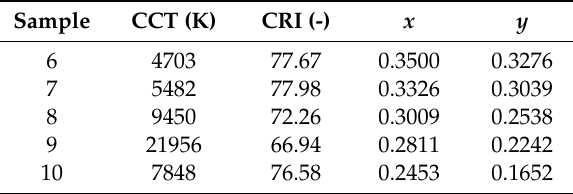
Figure 13. Measured CRI ( a ) and CCT ( b ) values for samples 6–10 with excitation using the LD PL450B. Table 6. CCT, CRI and color coordinates for samples